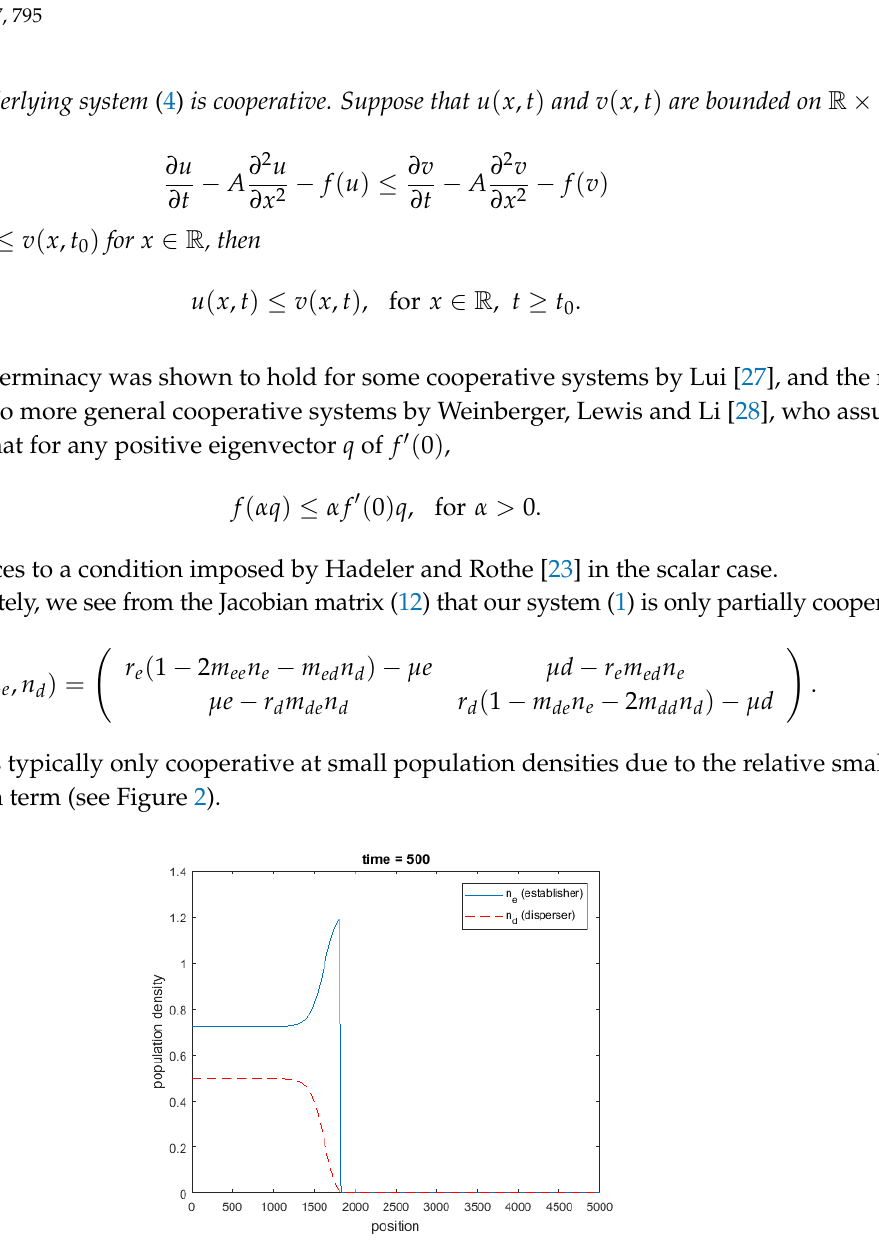
Figure 2. Solution of the system (1) with parameter values: D e = 0.3, D d = 1.5, r e = 1.1, r d = 0.2, m ee = 1.0/1.2, m dd = 1.0, m ed = 0.8, m de = 0.7, µ e = 0.001, µ d = 0.00025. A Heaviside step function was used as initial condition for each